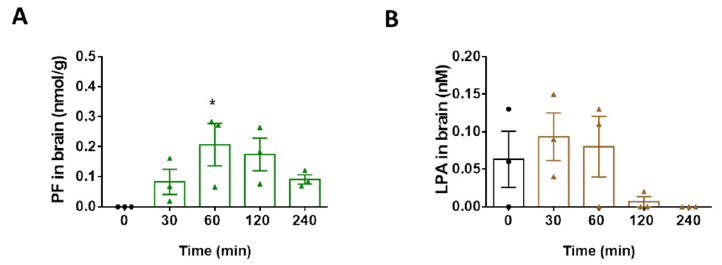
Figure 7. PF8380 crosses the blood–brain barrier and attenuates LPA levels in mouse brain. Animals received PF8380 (‘PF’) dissolved in oral formulation vehicle at a dose of 30 mg/kg by gavage to get an indication about oral bioavailability. At the indicated times, mice were sacrificed, perfused, and brains were dissected and snap frozen. The tissue homogenates were extracted using a modified Bligh & Dyer HCl method. Quantification of ( A ) PF8380 (‘PF’) and ( B ) LPA in brain was performed by LC-MS/MS. Results are presented as mean values ± SEM of three mice per group (* p < 0.05 compared to control; one-way ANOVA with Bonferroni